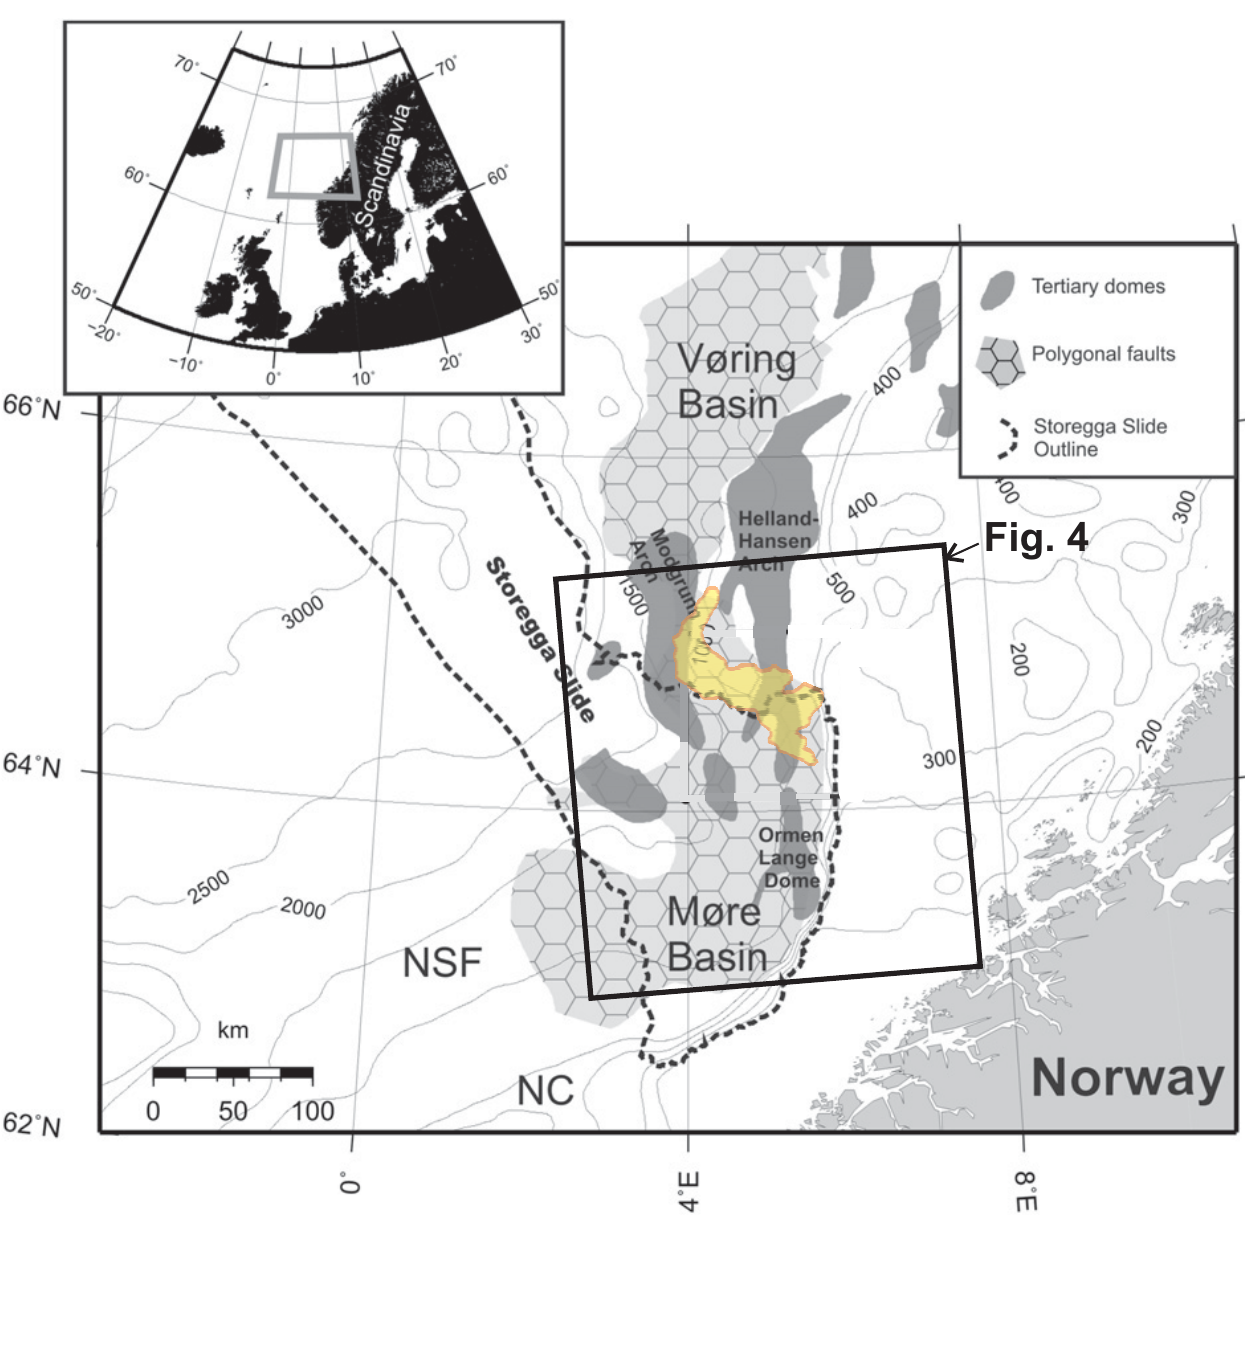
Figure 1. Location of the Nyegga study area, offshore mid-Norway. The study area rests on the north flank of the Storegga slide, approximately 135 km north of the Ormen Lange gas field. The main Nyegga gas hydrate prospect, based on the interpretation of the bottom simulating reflection (BSR), is emphasized in yellow. A detailed map illustrating the extent of the gas hydrate zone, as well as the key data used is provided in Figure 4. Figure modified from Weibull et al.